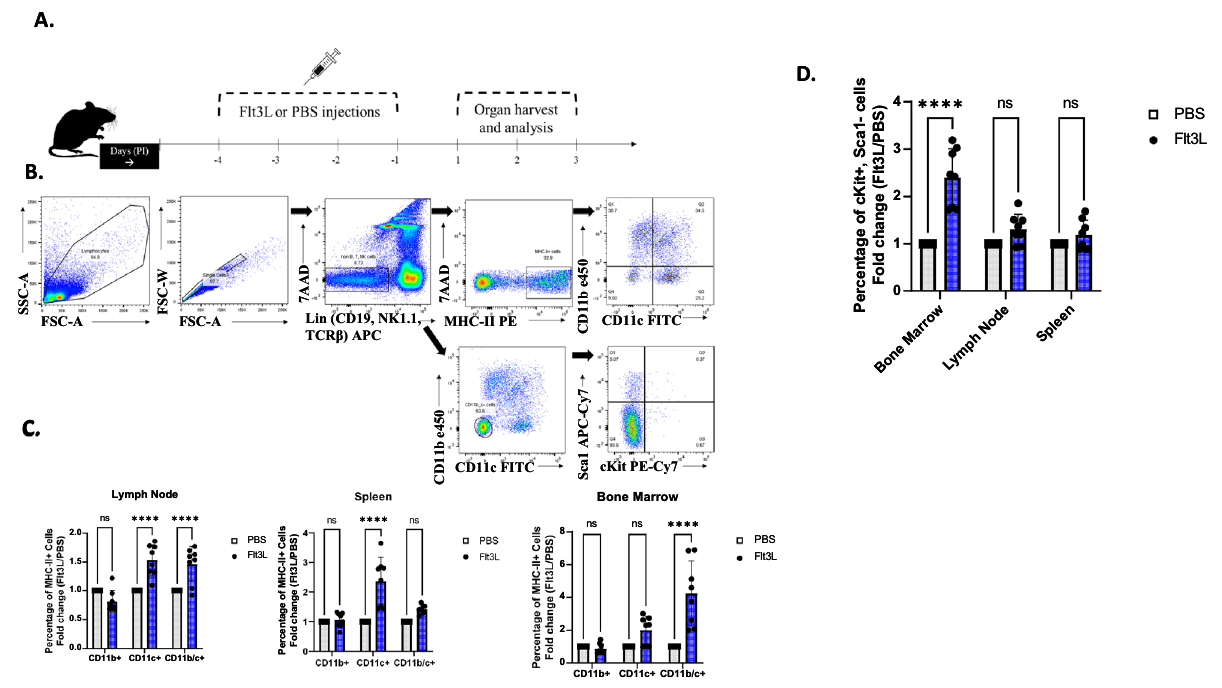
Figure 1. FL causes an increase in percentage of APC subsets and APC progenitors. ( A ) Experimental design as follows: 18 B61X2 mice were grouped: 9 were injected with 10 µg/100 µl of FLT3L, and the remaining 9 with 100ul of PBS for 4 consecutive days. Injections were performed intraperitoneally. After the 4th injection (labelled PI = post injection) , 8 mice/group were sacrificed on day 1 PI, and 3 mice sacrificed/group each subsequent day. Bone marrow, spleen, and lymph nodes were isolated, crushed, and stained with fluorescent markers. ( B ) Representative dot plots from the lymph node illustrating the gating strategy for CD11b and CD11c (top), and Sca1 and cKit (bottom). ( C ) Day 1 post-IP injection results of the DC subsets as a percentage of MHC-II+ cells, shown from Lymph Nodes (left), Spleen (middle), and Bone Marrow (right). Results are tabulated from two experiments (N = 3/group, N = 5/group) and normalized to the fold change of Flt3L-injected group/control group for each respective experiment. Grey rectangle = control group, Blue = Flt3L-injected group. (****) indicates statistical significance, P value ≤ 0.0001. ( D ) Day 1 post-IP injection results of cKit+, Sca1− cells from the Bone Marrow, Lymph Nodes and Spleen. Results are tabulated from two experiments (N = 3/group, N = 5/group) and normalized to the fold change of Flt3L-injected group/control group for each respective experiment. Grey rectangle = control group, Blue = Flt3L-injected group. (****) Indicates statistical significance, P value < Flt3L affects composition of CD4+ and CD8+ T cell subsets. With the changes observed in the APC compartments, we next sought to examine if there were any corresponding changes in the T cell compartments. Cells from the lymph node (LN), spleen, and bone marrow were first analyzed for the quantity of CD4+ versus CD8+ numbers. On all three days of mice examined, there was no observed change in the absolute numbers of live CD4+ or CD8+ T cells in any of the three tissue sites examined with or without Flt3L (Fig. 2; Suppl. S2B). In our flow-cytometry gating of T cells (Suppl. Fig. S2A), we first gated on TCRβ+ cells, followed by staining of CD4 and CD8, which allowed us to exclude any potential double-negative (DN) cells, or Natural Killer T cells (NKT). When comparing the fold-change of the results experiments using this gating vs. previous experiments’ gating which did not include a specific CD8 gate, our results remained largely unchanged, indicating that the DN and NKT cells are low frequency, and most likely do not contribute significantly to any of the Flt3L-induced effects. While the absolute number of CD4+ or CD8+ T cells did not change with Flt3L administration, it remained conceivable that subsets within these T cell compartments were altered. Using the canonical surface markers associated with memory phenotypes in mice, CD44 and CD62L, we first looked at the relative percentages of different CD44/CD62L T cell subsets: CD44-hi, CD62L-hi cells are typically classified as Central memory (T CM ), CD44-hi, CD62L-low cells as Effector memory (T EM ), and CD44-low, CD62L-hi cells as Naive (T N ) (Suppl. Fig. S2A). Among the CD4+ T cells from the lymph nodes and spleen, there was no difference on Day 1 PI in the T CM or T EM or naïve populations in mice that received Flt3L versus PBS (Fig. 3A). Strikingly, however there was a significant increase in the proportion of CD4+ CD44-low/CD62L-low cells in these tissues on Day 1 PI (lymph node p < 0.05, spleen p = 0.0007) (Fig. 3A). In the bone marrow, there was an observed decrease in the proportion of T CM and naïve CD4+ T cells, with a corresponding increase of T EM cells (T EM p = 0.0077, T CM p < 0.05, Naïve p < 0.0001) (Fig. 3A) In the CD8+ T cell population, there appeared to be an increase in the percentage of the CD44-low/CD62L-low cells in the lymph node and spleen ( lymph node p = 0.0392, spleen p < 0.0001) (Fig. 3B). Similar to the CD4+ T cell compartment, in the bone marrow on Day 1 PI there was a significant increase in the proportion of T EM cells (Fig. 3B). Overall, our results indicate a significant shift in CD4+ and CD8+ T cell subsets